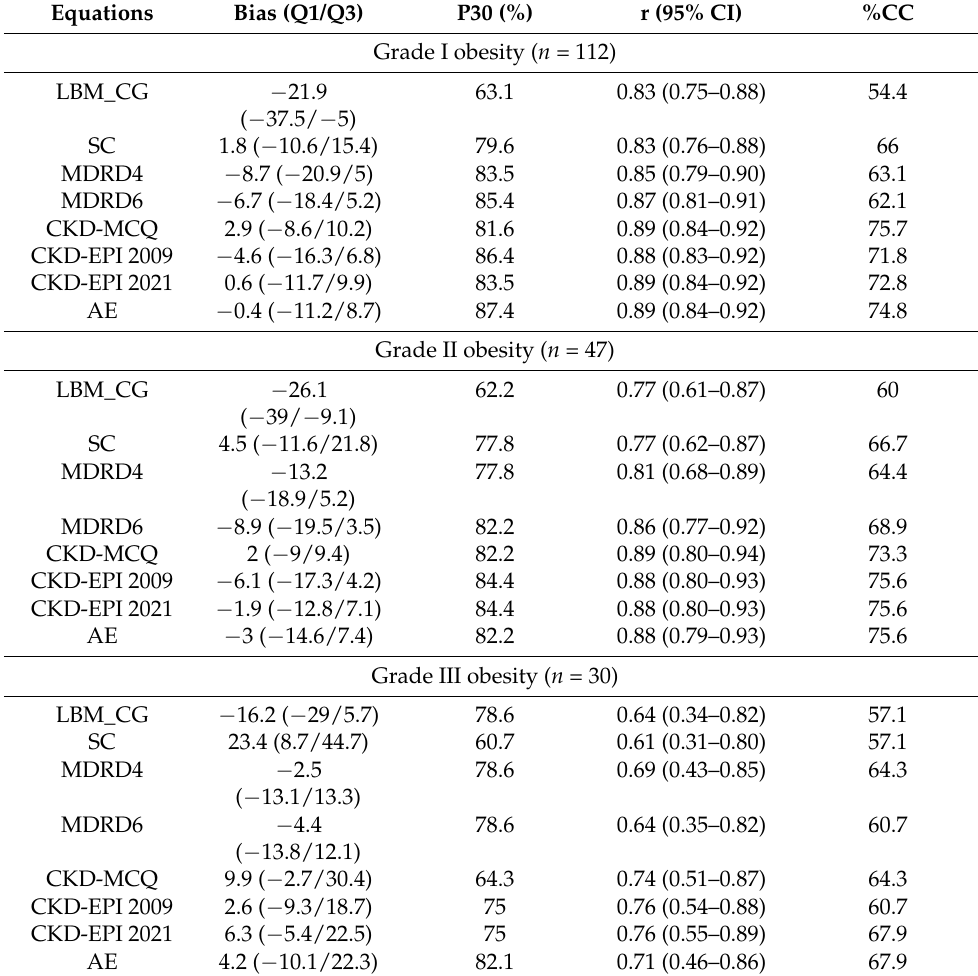
Table 3. Performance of the different equations to estimate the mGFR in the IVS differentiating between the 3 degrees of obesity ( n =